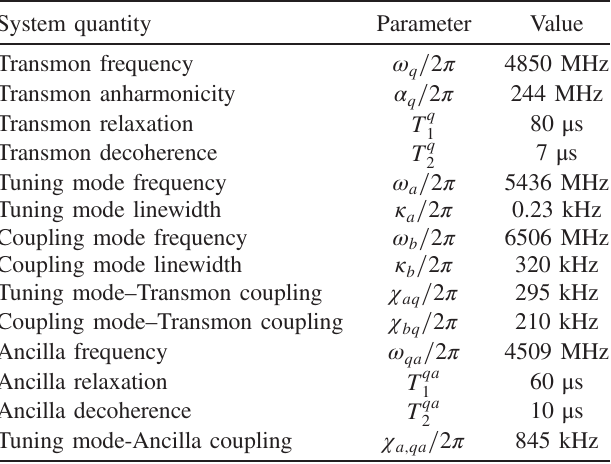
TABLE I. List of static system